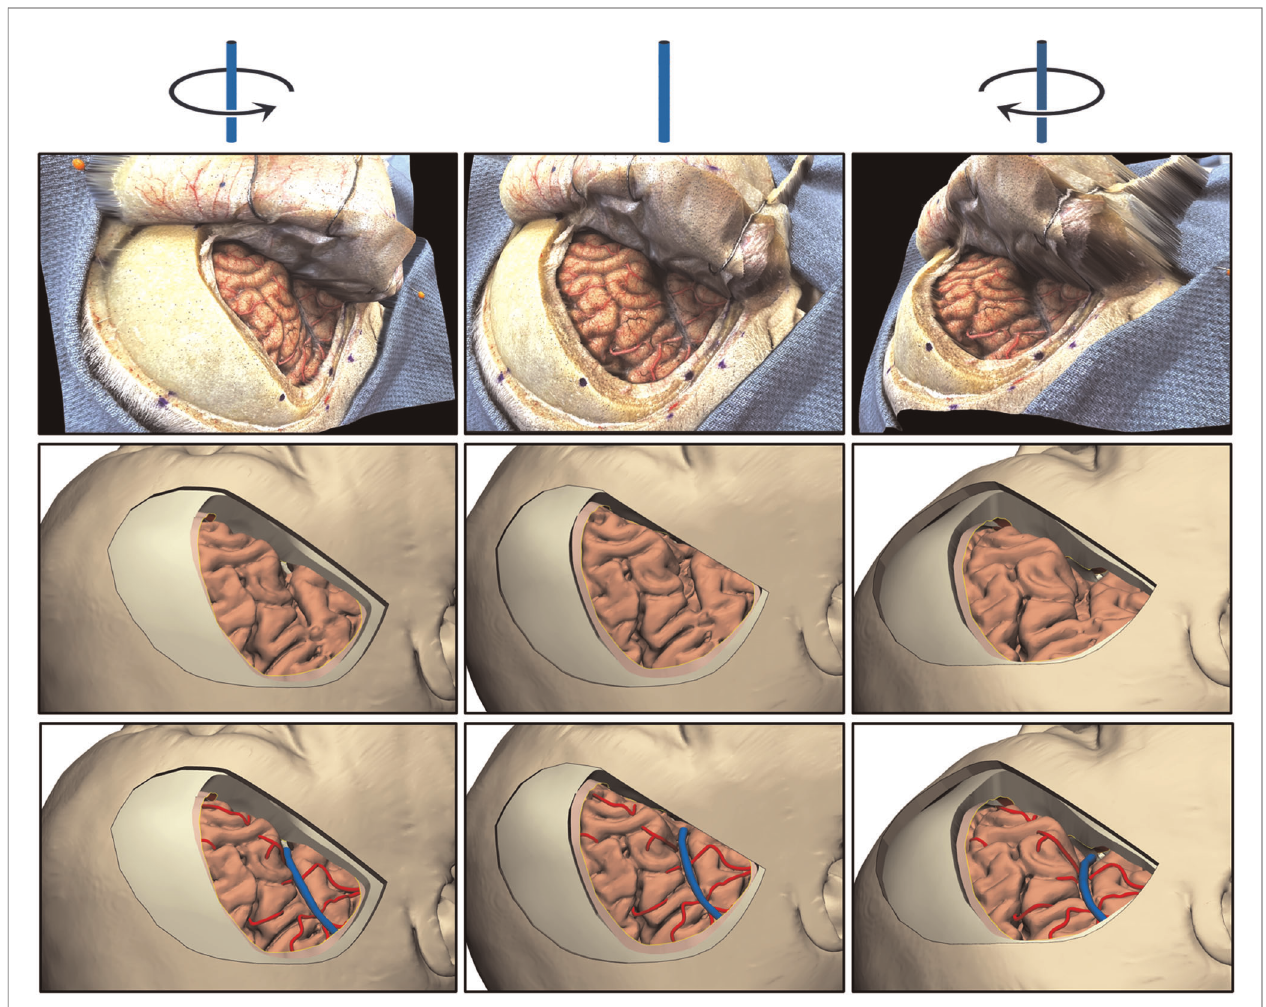
FIGURE 7 | Three rotations (columns) of real-world and two 3D models. Cadaveric photographs are shown in the top row. Both the 3D images obtained from a single 2D photograph via monocular-depth estimation technique (middle row) and the 3D virtual model generated from neuroimaging data (bottom row) can be rotated and matched in 3D space. Used with permission from Barrow Neurological Institute, Phoenix, Arizona